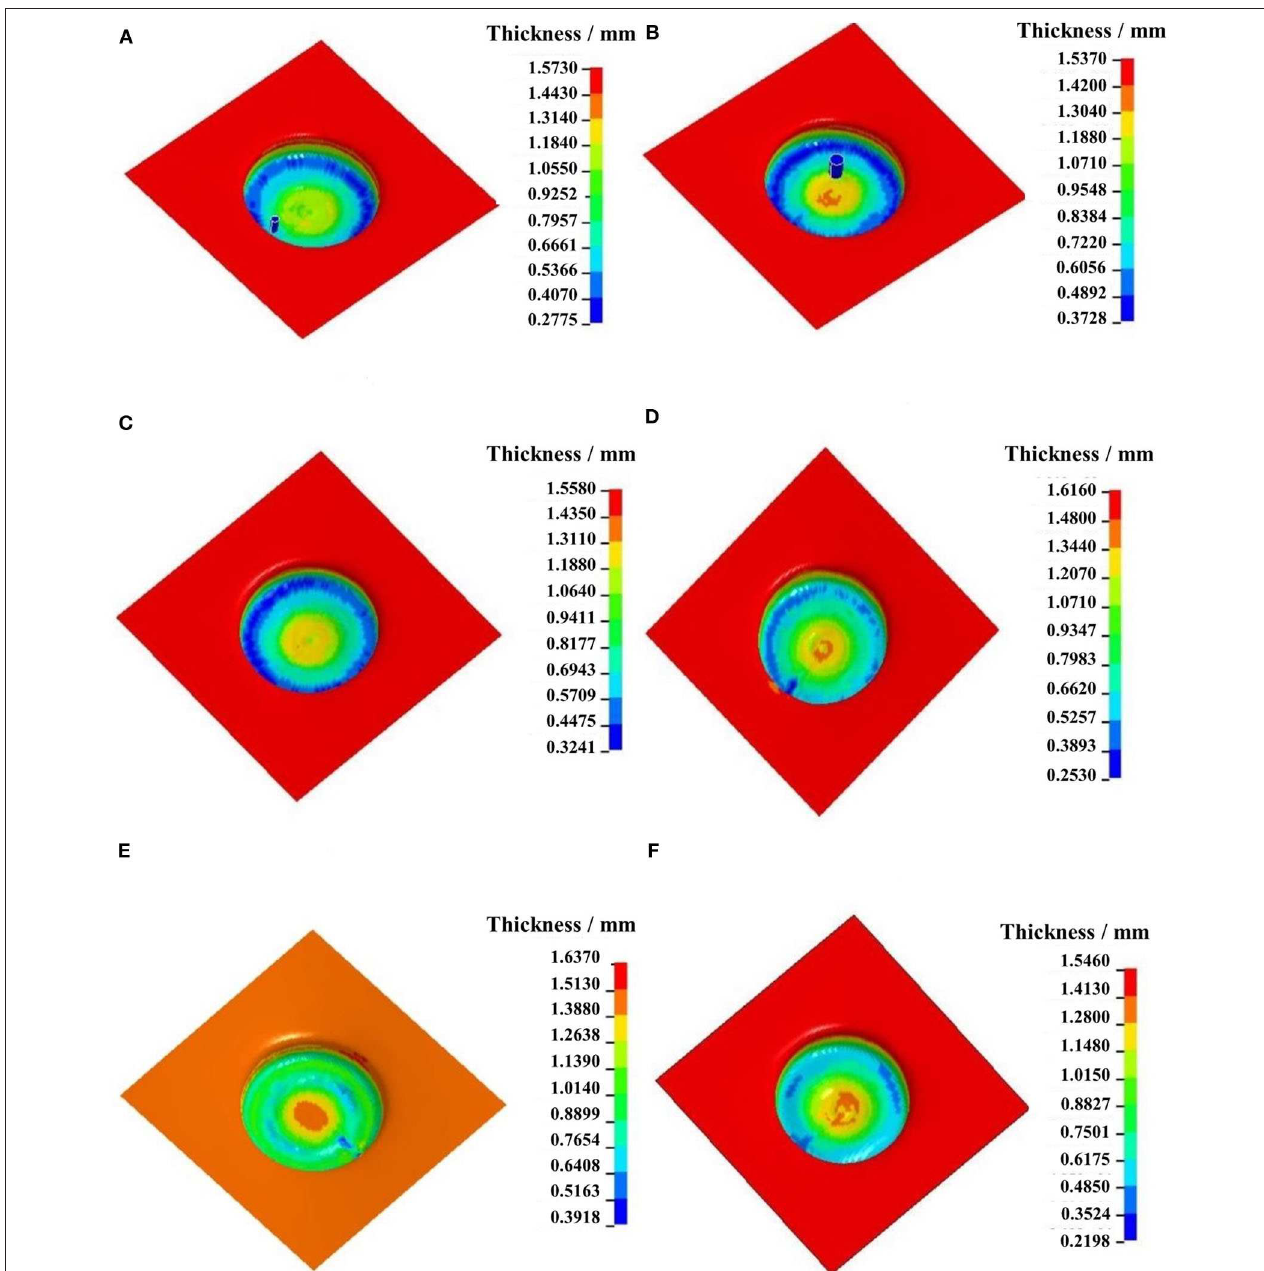
FIGURE 8 | Wall thickness contour of formed part with different process parameters: (A) tool diameter of 6mm; (B) tool diameter of 10mm; (C) interlayer spacing of 0.3mm; (D) interlayer spacing of 1.0mm; (E) feed rate of 250 mm/min mm; (F) feed rate of 450 mm/min.